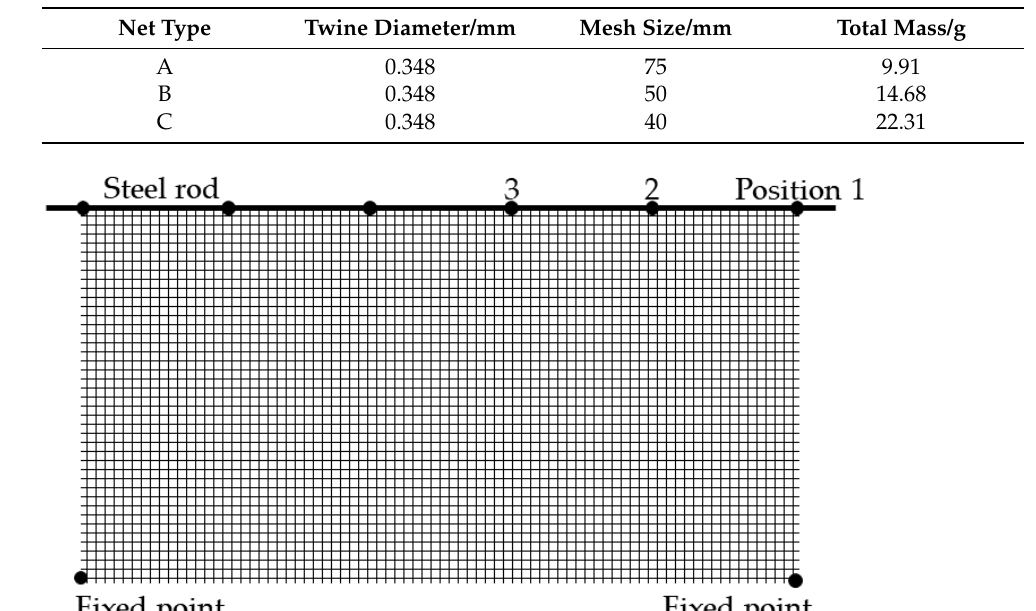
Table 1. The net types.